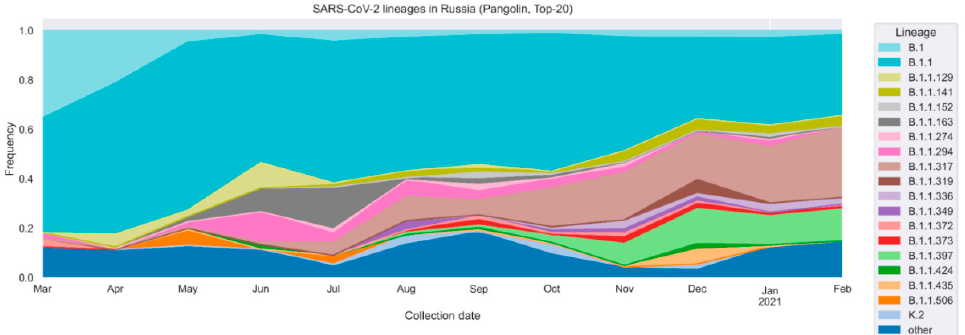
Figure 1. SARS-CoV-2 genetic lineages distribution in Russia. Data were collected from GISAID and visualized to represent 20 most frequent lineages in Russia, PANGOLIN nomenclature.